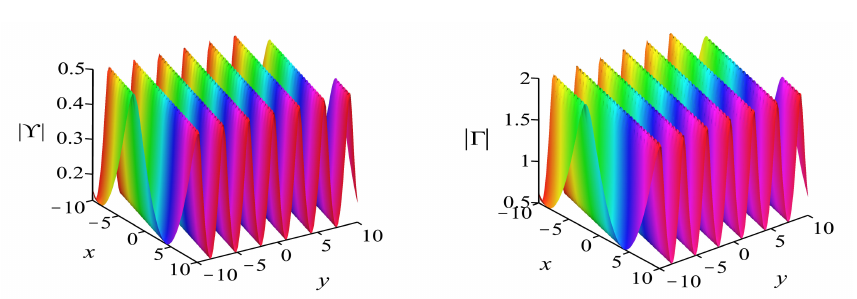
Figure 2. The evolution of solution (44) with α = 0.5, β = γ = 2, ν = λ = η = 1, ω = σ = − 2, z = − 0.5, and t = 0.1.